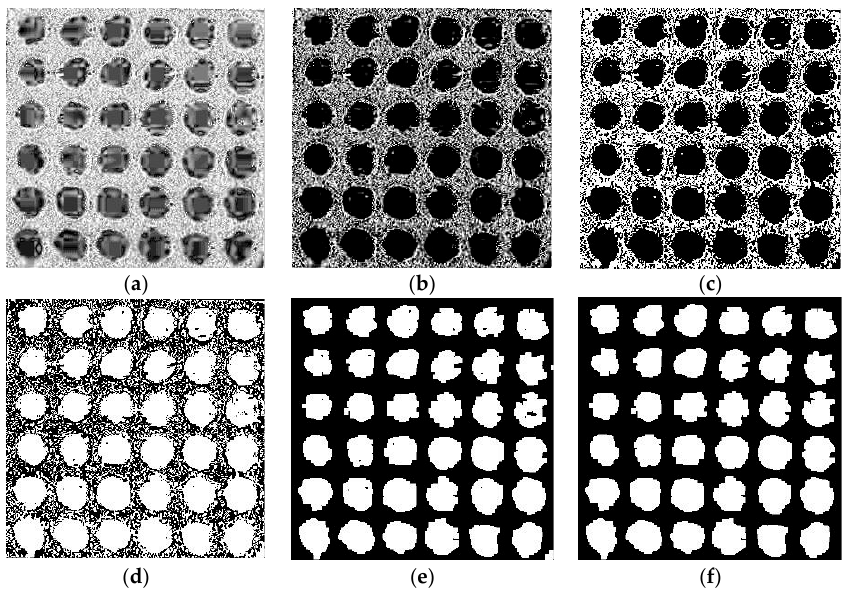
Figure 8. ( a ) saturation component; ( b ) adjusting saturation component; ( c ) binarization of saturation component; ( d ) acquiring the opposite image; ( e ) open operation; and ( f ) results of saturation component processing.